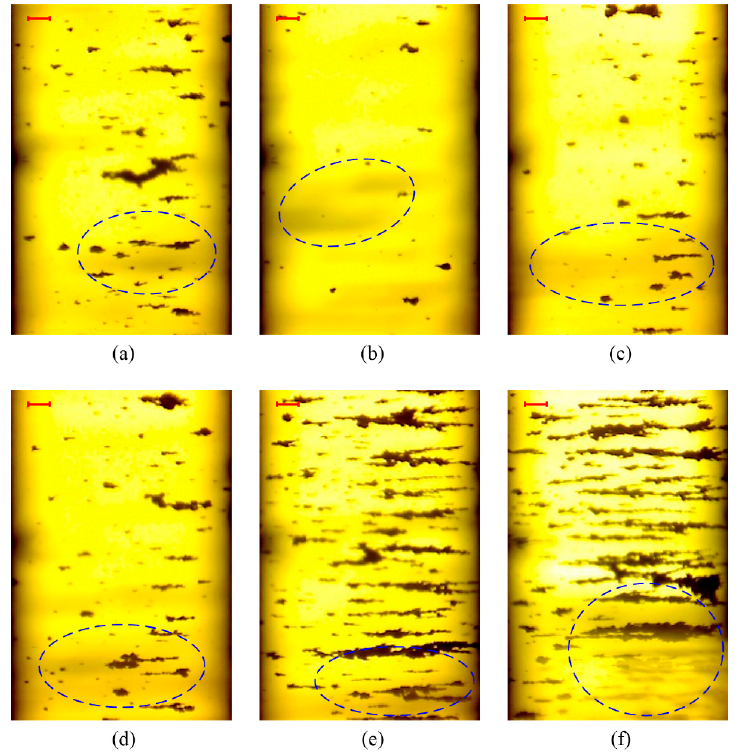
µ m): ( a ) 22 min; ( b ) 2 h